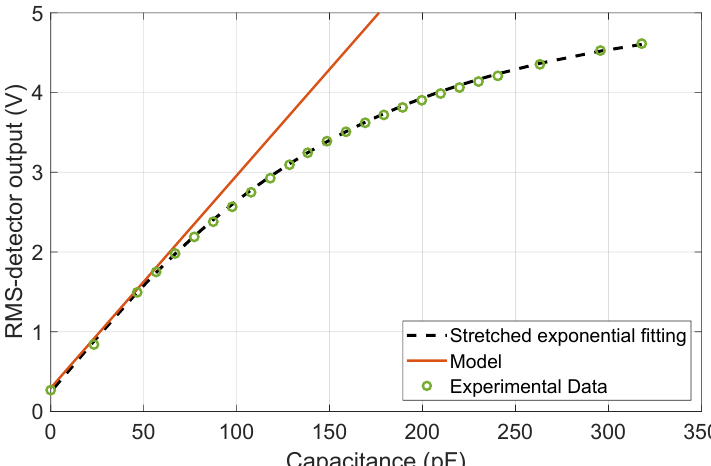
Figure 4. A possible output voltage–capacitance characteristic of the circuit. The green markers represent the voltage output of the RMS circuit corresponding to the constant capacitors used for the calibration; the black dashed line is an exponential regression function; the red line represents circuit output as estimated by the model